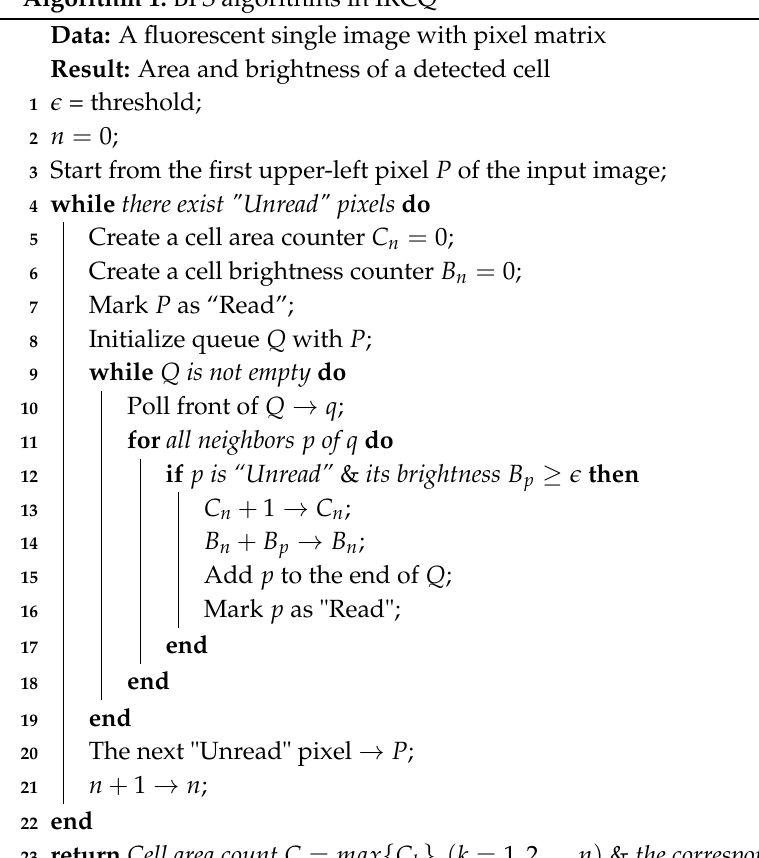
Algorithm 1: BFS algorithms in IRCQ Data: A fluorescent single image with pixel